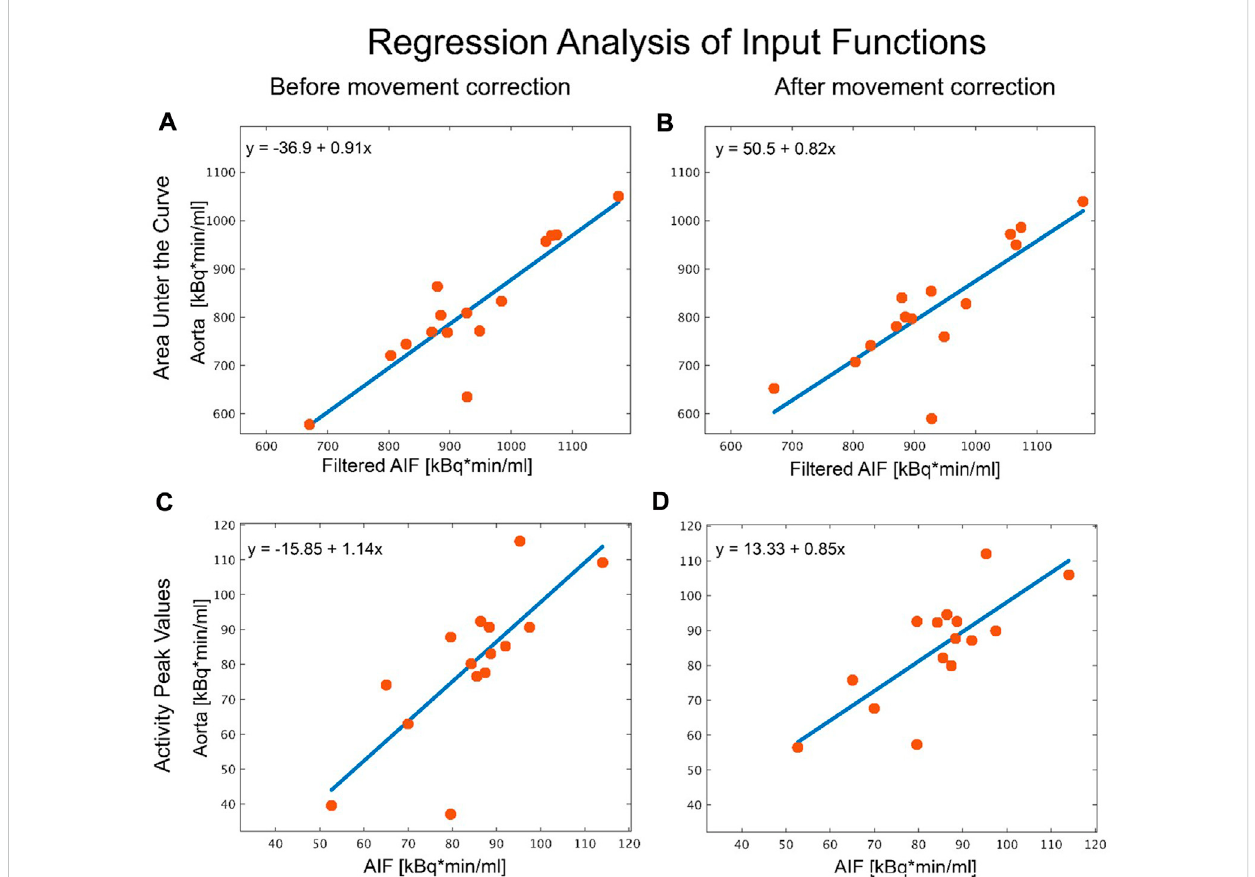
FIGURE 4 Analysis of the different aorta input functions. Regression analysis comparing peak values and area under the curve (AUC) of the arterial input function (gold standard) to an image derived input function (IDIF) placed in the aorta before and after movement correction. (A) AUC analysis of the automatic vendor generated IDIFintheaortabeforemovement correctionvs. theAIF. (B) AUCanalysisofthemanually placed volume ofinterest(VOI)in theaortaaftermovementcorrectionvs.theAIF. (C) Asin (A) ,regressionanalysisofpeakvaluesintheautomaticvendorgeneratedVOIvs.AIFbefore and (D) in the manually created VOI after correcting for movement vs. AIF. The source of the discrepancy between the IDIF and AIF method for the two outliers stem from misplaced VOIs when leading to discrepancies in the IDIF, where movement correction had no effect, due to it being incorrectly placed from the